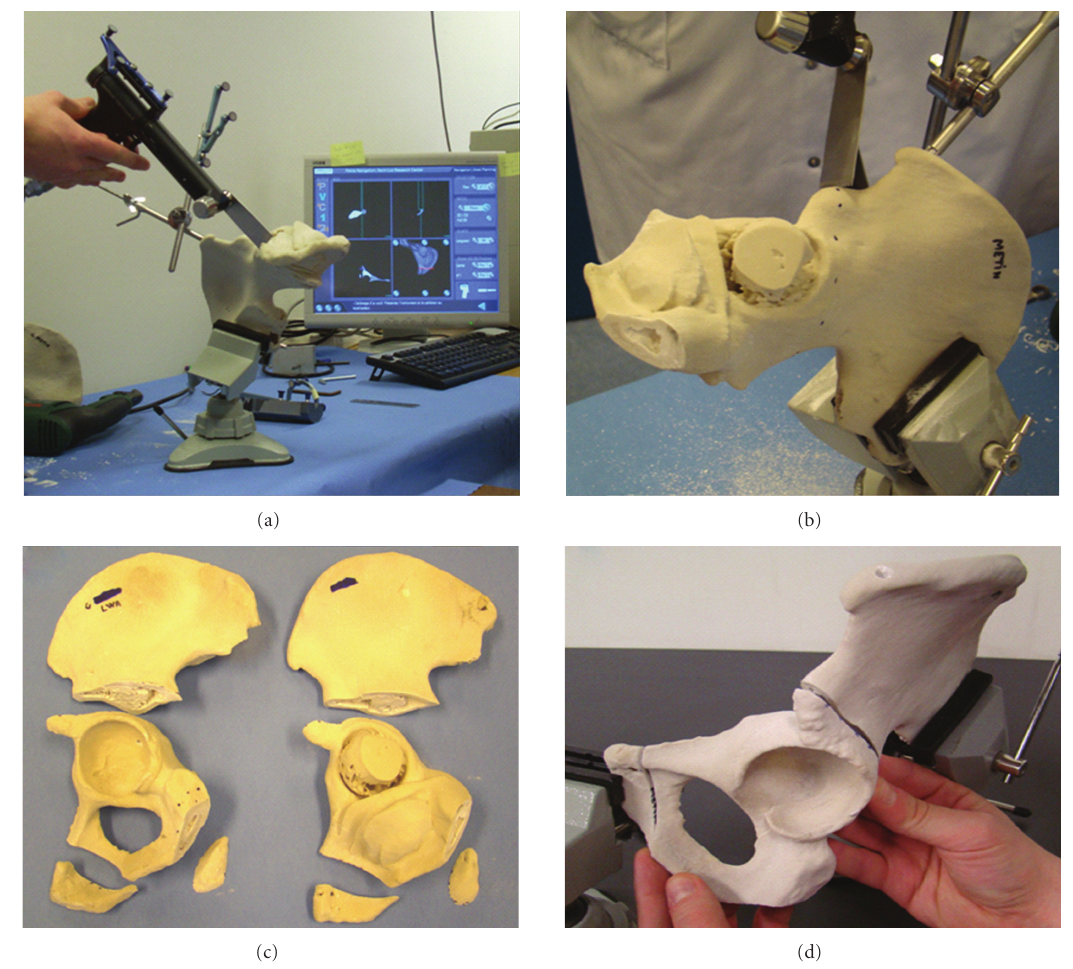
Figure 2: (a) A model of the patient’s iliac bone with the tumor was created by rapid prototyping. A preoperative rehearsal of the tumorous resection was realized with the computer-assisted navigation system. (b) Prototype of the patient with the tumor. The osteotomy line was first traced with the navigation pointer to mark up the entry point of the saw. (c) Computer-assisted system allowed us to cut the 2 iliac bone prototypes: the patient (on the right) and the allograft (on the left). The cutting planes are identical for the two procedures. (d) The fitting of the graft model into the patient’s iliac bone model is